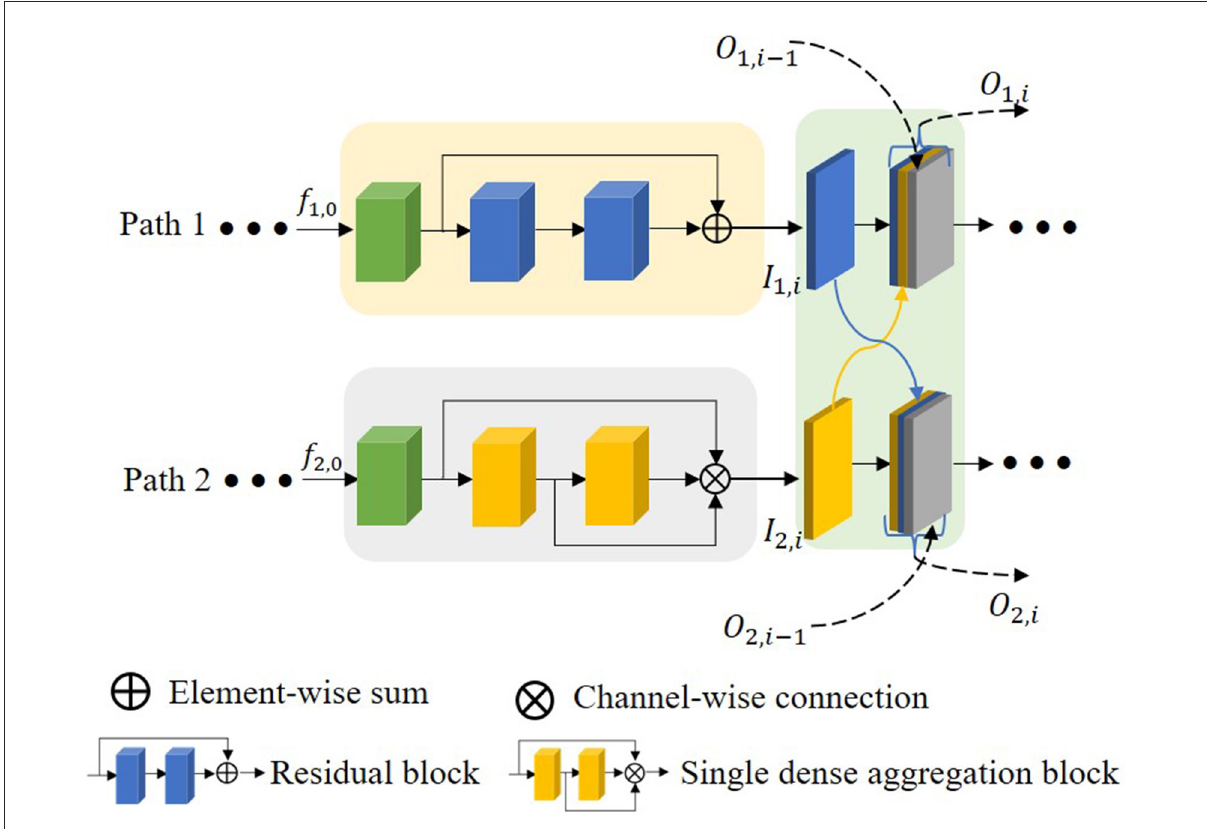
FIGURE7 The proposed multiscale feature fusion block.